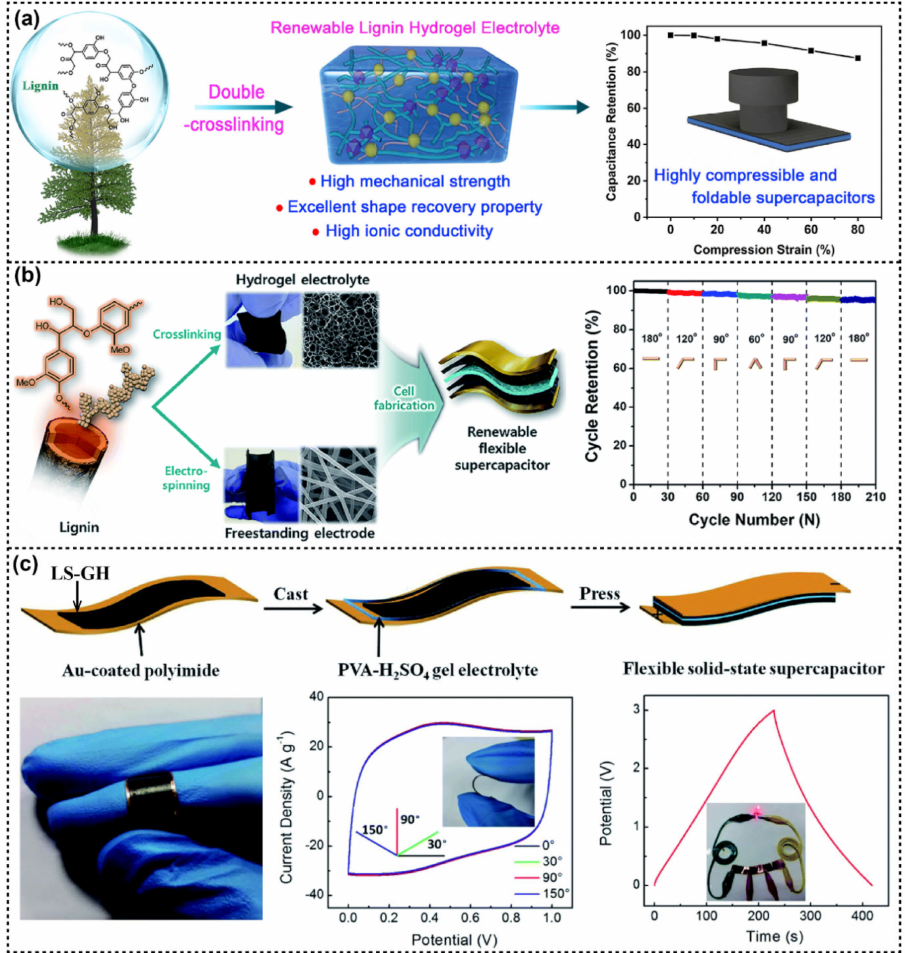
Figure 6. ( a ) Schematic illustration of a renewable double-crosslinked lignin hydrogel formed by sequential chemical crosslinking and physical crosslinking strategies, which could be an excellent hydrogel electrolyte for a highly compressible and foldable supercapacitor. Reproduced with per- mission from ref. [81]. Copyright 2020, Elsevier. ( b ) Experimental scheme for the fabrication of all-solid-state flexible supercapacitors based on lignin hydrogel electrolyte and lignin/PAN carbon nanofiber electrodes and cycling stability of lignin-based supercapacitor over 200 cycles under dy- namic mechanical stress. Reproduced with permission from ref. [82]. Copyright 2017, Royal Society of Chemistry. ( c ) Schematic diagram of the fabrication process of the LS–GH flexible solid-state supercapacitor, digital photos of the flexible device, and electrochemical performance of the flexible device. Reproduced with permission from ref. [84]. Copyright 2019, Royal Society of